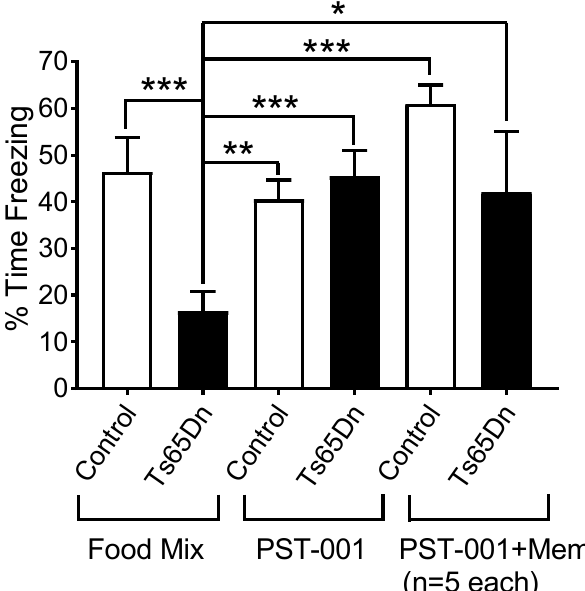
Figure 7. Contextual fear conditioning model. Parallel experiments showing the effect of PST-001 in the food on the freezing time in the contextual fear conditioning model and the combined effect of PST-001 in the food and acute memantine injections. Data represent mean ± SEM and statistical significance is expressed as *, ** and ***, for p < 0.05, p < 0.01, and p < 0.001, respectively.